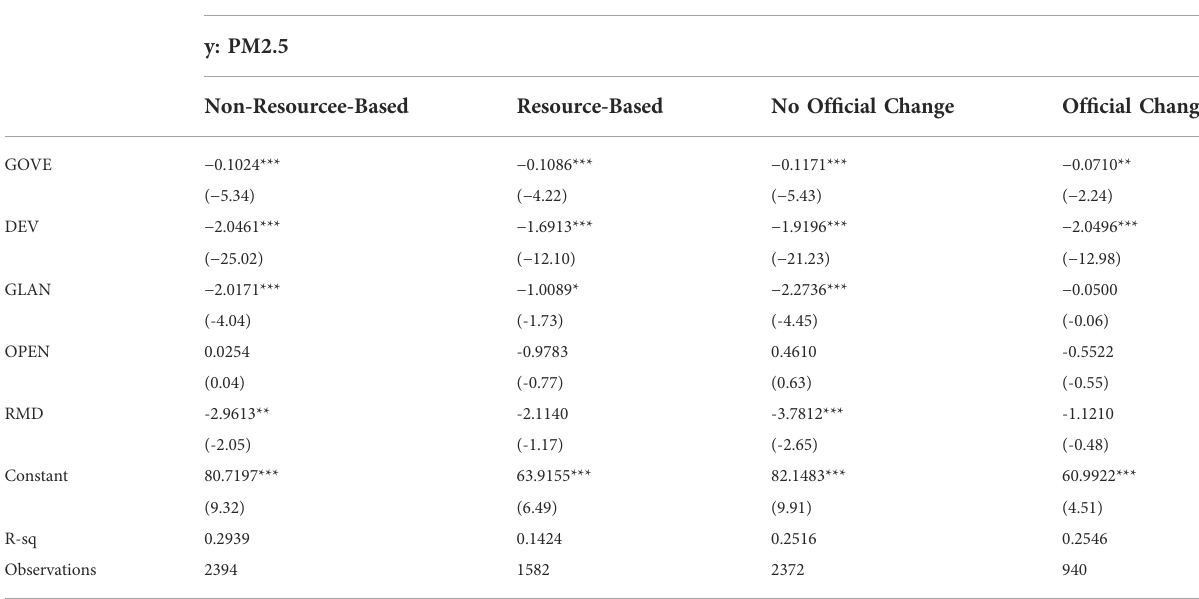
TABLE 7 Heterogeneity of resource endowments and of fi cial changes.